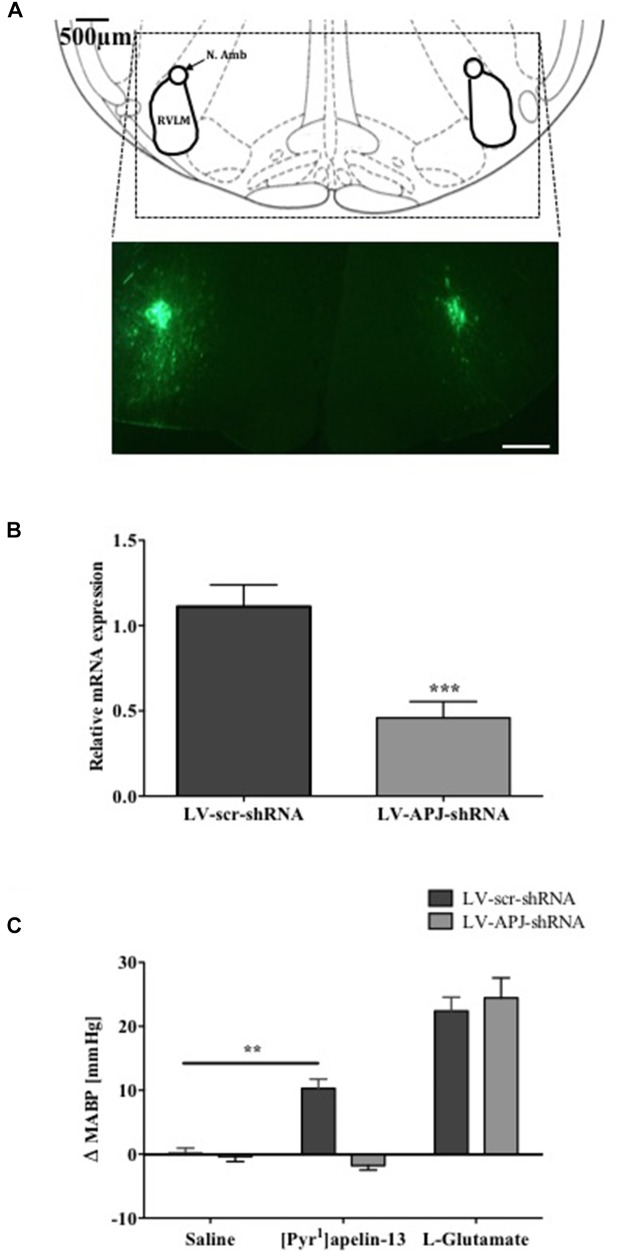
Effects of LV-APJ-shRNA microinjection on aplnr expression and function. (A) Schematic diagram showing the anatomical location of the RVLM in the brainstem targeted with lentivirus injections, adapted from Paxinos and Watson (1998, Figure 68) and representative fluorescent, photomicrographs showing eGFP expression within the RVLM of a WKY rat 25 days after virus injection. Scale bar = 500 μm. (B) Relative aplnr expression 25 days after bilateral microinjection of either LV-scr-shRNA (dark gray bar, n = 18) or LV-APJ-shRNA (light gray bar, n = 18) to the RVLM. (C) Change in MABP following bilateral microinjection of saline, [Pyr1]apelin-13 (200 pmol, 100 nl−1 side−1) and glutamate (1 nmol, 100 nl−1) to the RVLM of LV-scr-shRNA, (dark gray bars, n = 18) and LV-APJ-shRNA injected (light gray bars, n = 18) rats. Data shown is mean ± SEM ∗∗P < 0.01, ∗∗∗P < 0.001.